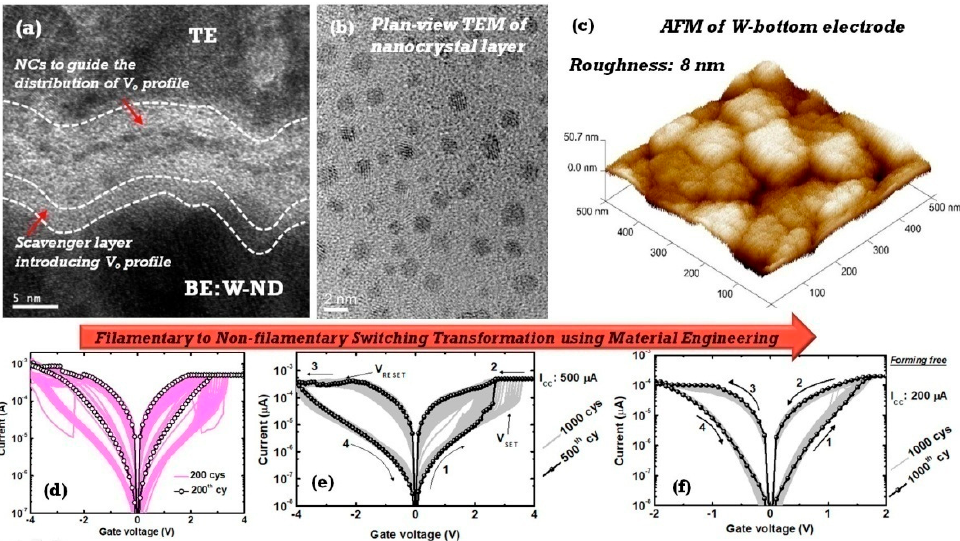
Figure 11. ( a ) The high-resolution transmission electron microscopic image and ( b ) the plan-view transmission electron microscopic image of the W / AlO x / IrO x -NCs / AlO x / IrO x structures. ( c ) The atomic force microscopic image of the nano-dome W-bottom electrode with 8 nm of surface roughness. The resistive switching performance in devices ( d ) without any nanostructure, ( e ) with single nanostructure, and ( f ) with dualnanostructures. Due to nonfilamentary switching in the dual-nanostructured device, highly reliable resistance states are achieved. (Reproduced from Adv. Electron. Mater. 2020, 2000209, with the permission of John Wiley and Sons Publishing [128].)